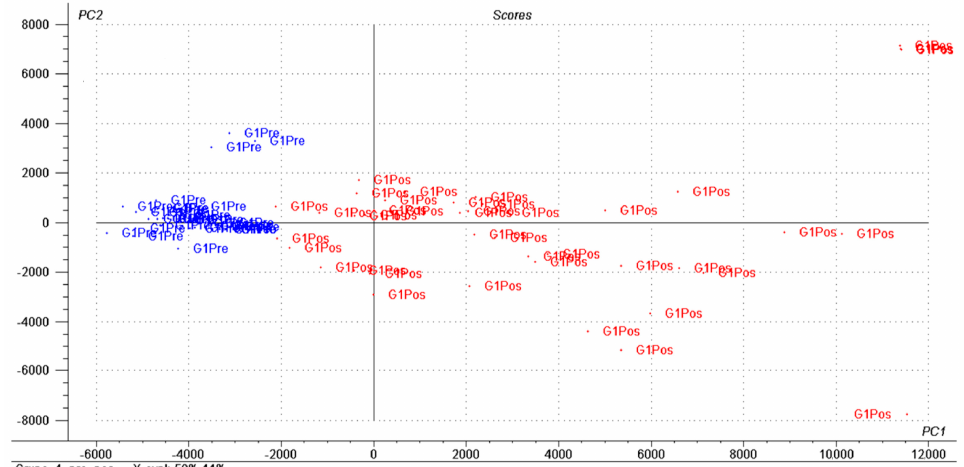
Figure 1. Graphical representation of the principal component analysis (PCA) comparing the metabolomic profiles of hypertensive women with excess weight before and after intervention with mixed dietary fiber (blue-preintervention, red-postintervention).